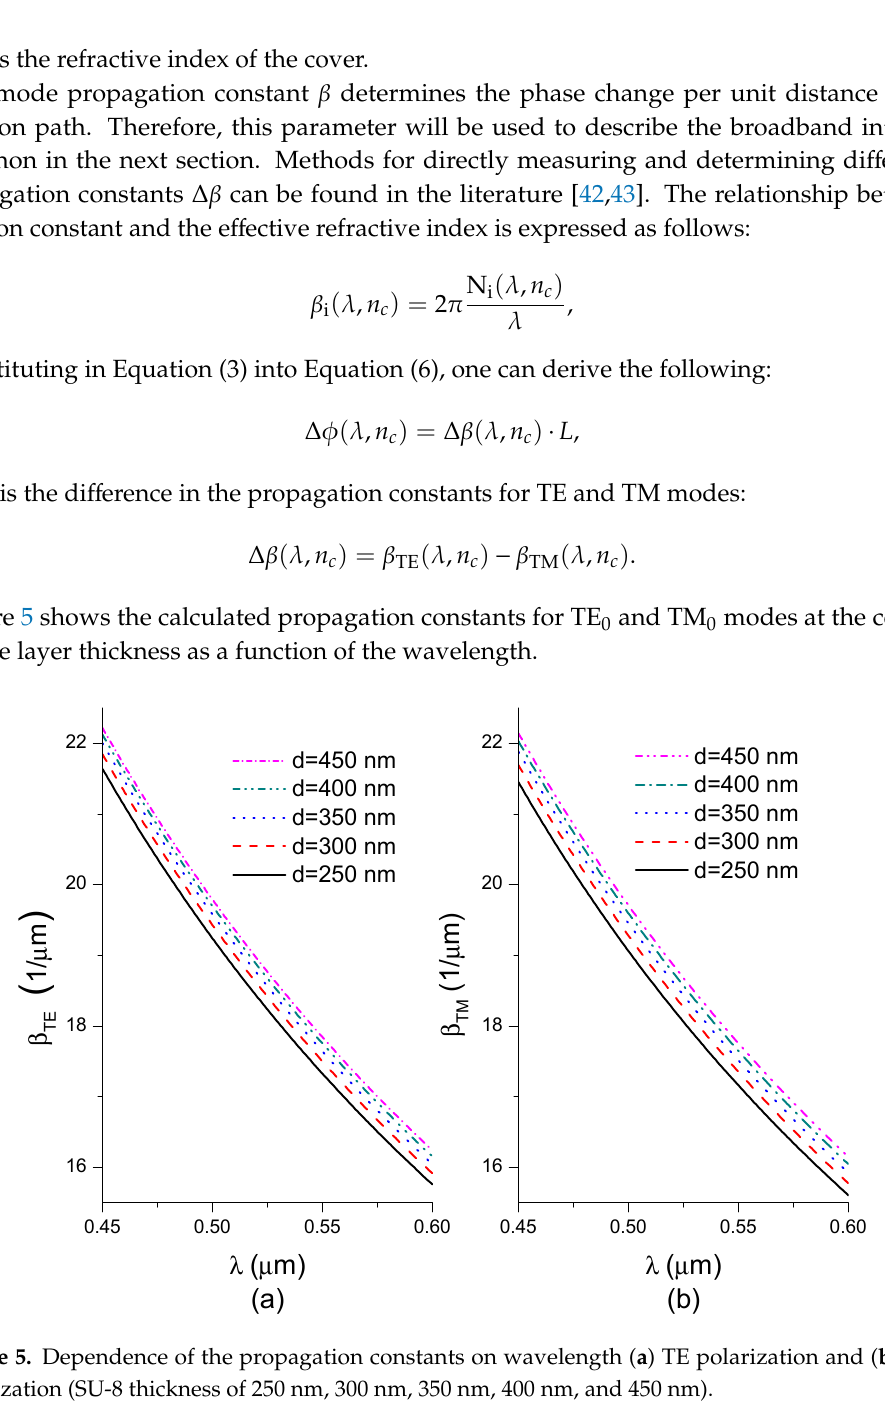
Figure 6. Difference in propagation constants as a function of wavelength.